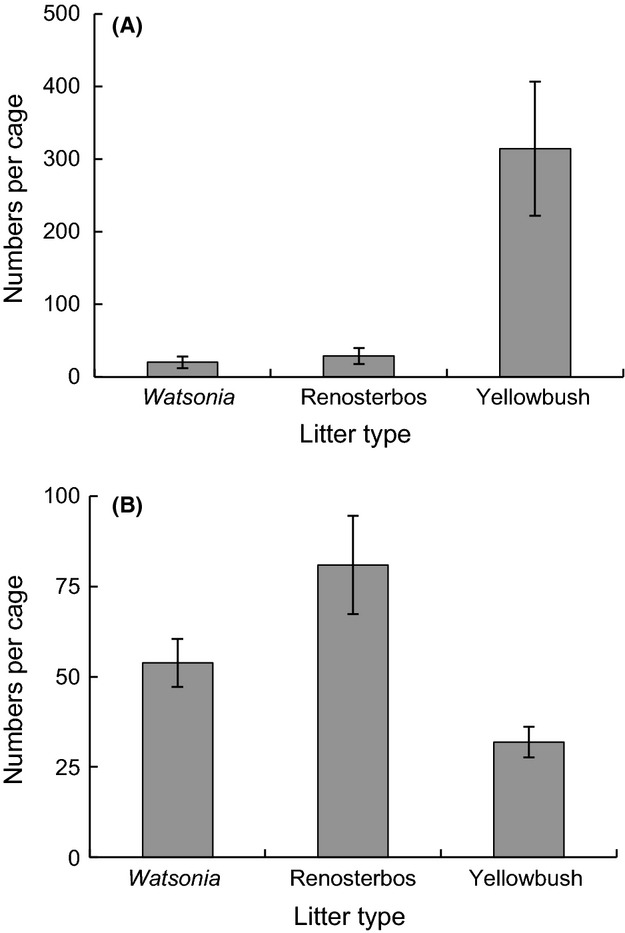
Numbers of individuals (±SE) per trap of each litter type, averaged over the three sampling dates. A = Hypogastrura manubrialis, B = all indigenous species combined. (Note differences in scale). n-values: 49 (Watsonia), 47 (renosterbos), 49 (yellowbush).